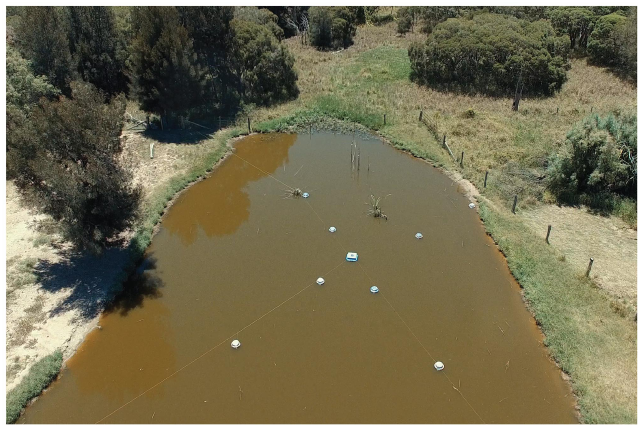
Figure A3. An oblique drone image showing a nine-floating-chamber deployment set-up targeting peripheral and central zones on a stock watering dam (Gatton 3).